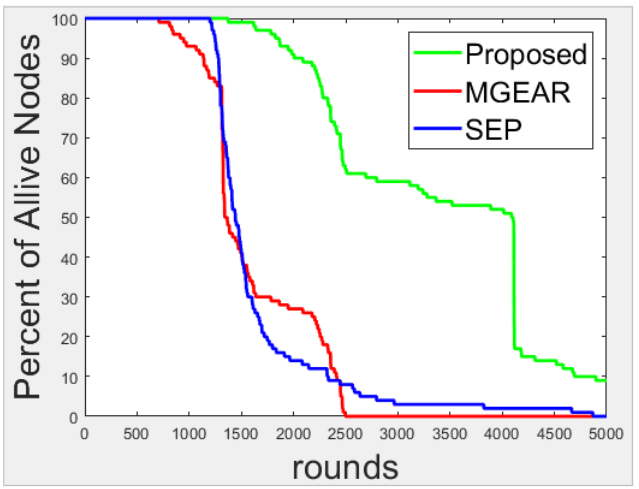
Figure 2. Number of alive nodes per